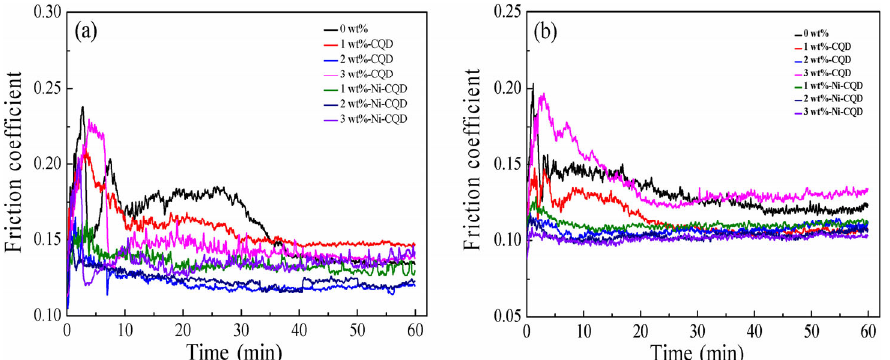
Fig. 6 Variation of friction coefficient as a function of the friction time under 100 N for 60 min at the different reciprocation speeds: (a) 17 mm/s; (b) 33